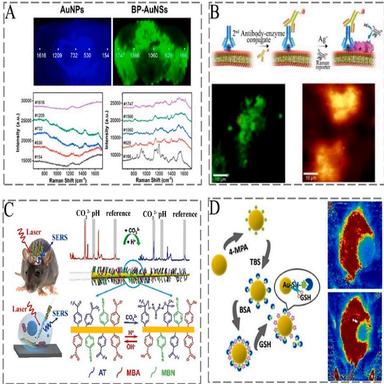
(A) SERS imaging of the whole structure of brain tissue from ref.)]. Copyright 2019 Elsevier. (B) SERS imaging for the detection of multiple proteins in APP/PS1 transgenic mouse brain tissue from ref. Copyright 2021 American Chemical Society. (C) SERS imaging for real-time localization and simultaneous quantitation of CO3 2− concentration and pH in living rat brain. from ref.. Copyright 2019 American Chemical Society. (D) SERS imaging is used to study the effect of T